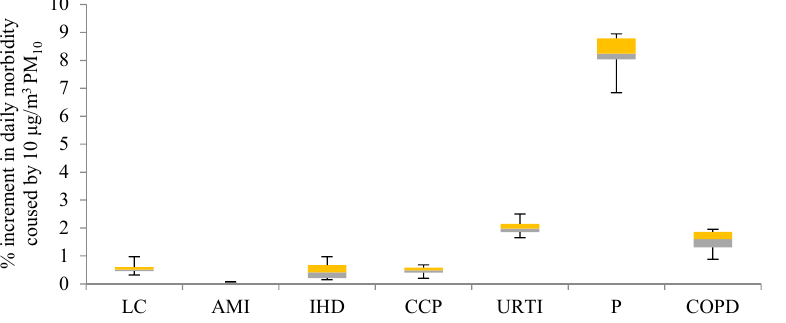
Figure 12. Box-plot analysis of percent increase of hospitalizations for each 10 μ g/m 3 increment of PM 10 .The lower (grey) and upper (yellow) limits represent the first (25P) and third (75P) quartiles, and the ends of the whiskers represent the minimum and the maximum values.